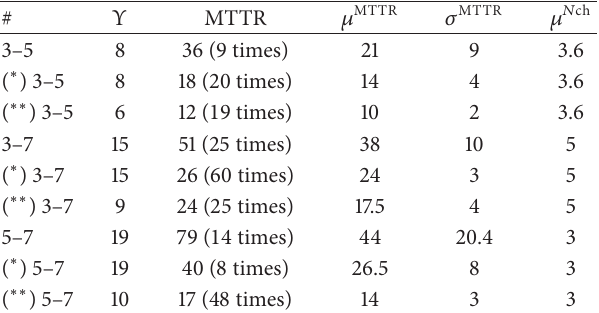
Figure 18: A-ETCH with the same sequences (5 channels).